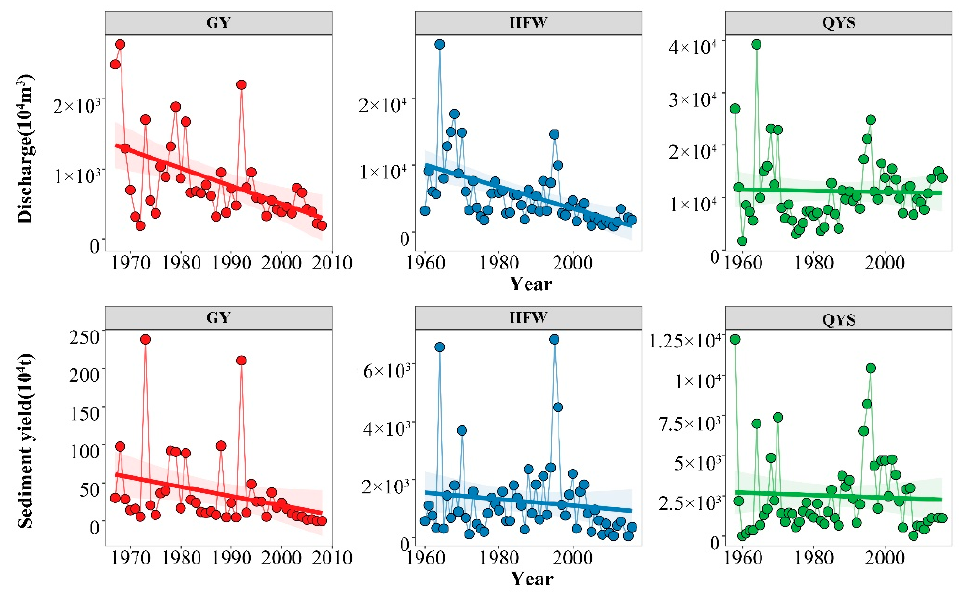
Figure 6. Annual river runoff and sediment discharge of GY, HFW, and QYS during 1960–2016. Table 2 presents the statistical analysis results based on the MK nonparametric test.